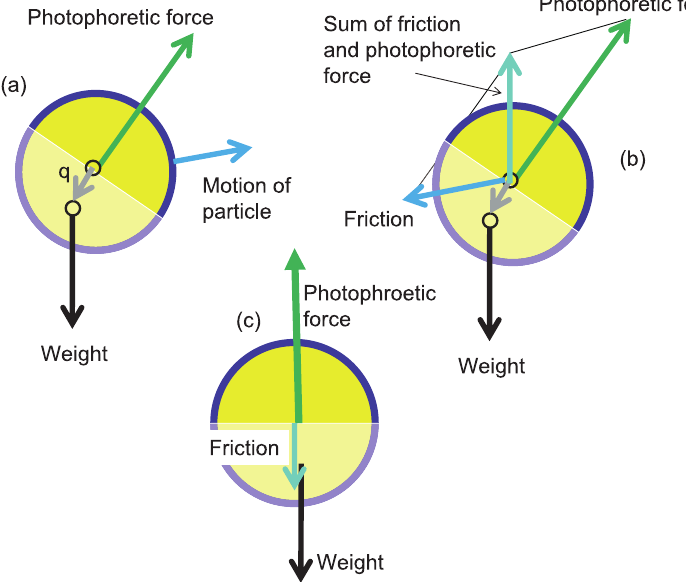
Fig. 11 Orientation of a particle by gravity: ( a ) The center of mass of the particles is displaced by a vector q . The photophoretic force (due to different accommodation coefficients) added to the weight of the particles causes a motion to the right. ( b ) The friction is a vector to the left ( b ), adding friction and photophoretic force yields a vertical vector. Since the two vertical vectors are anchored at different points, a torque on the particle forces it to rotate ( c ) until the two anchor points are above each other ( c